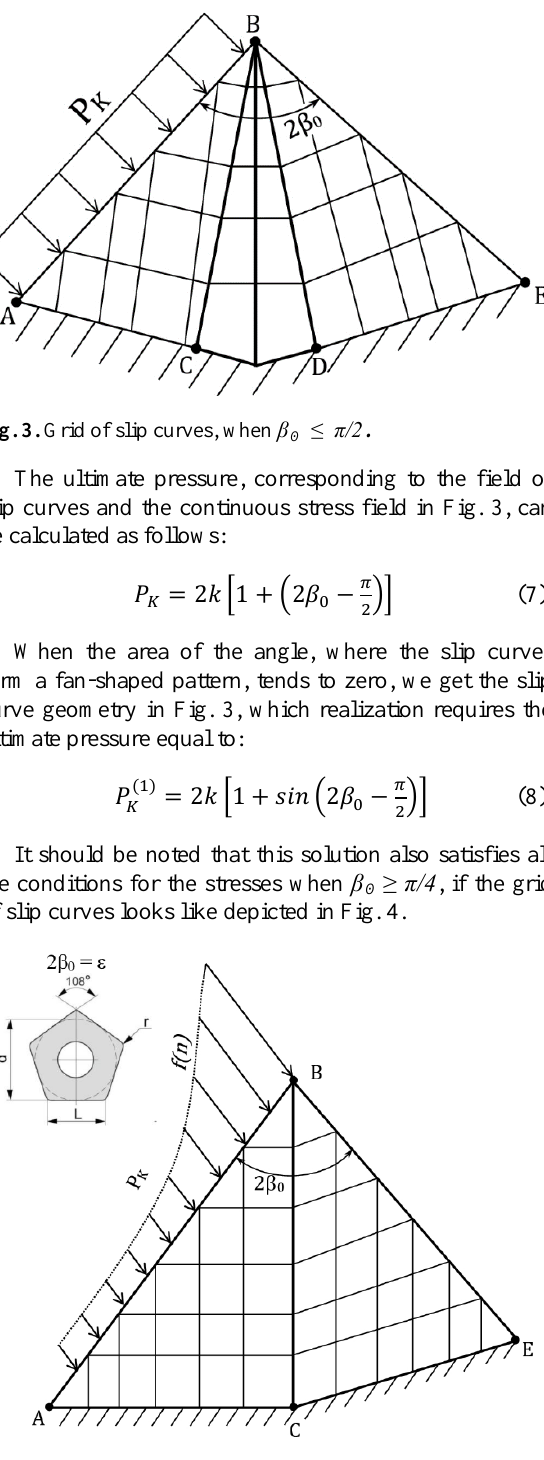
Fig. 4. Grid of slip lines, when ε = 2β 0 ≥ π/2.